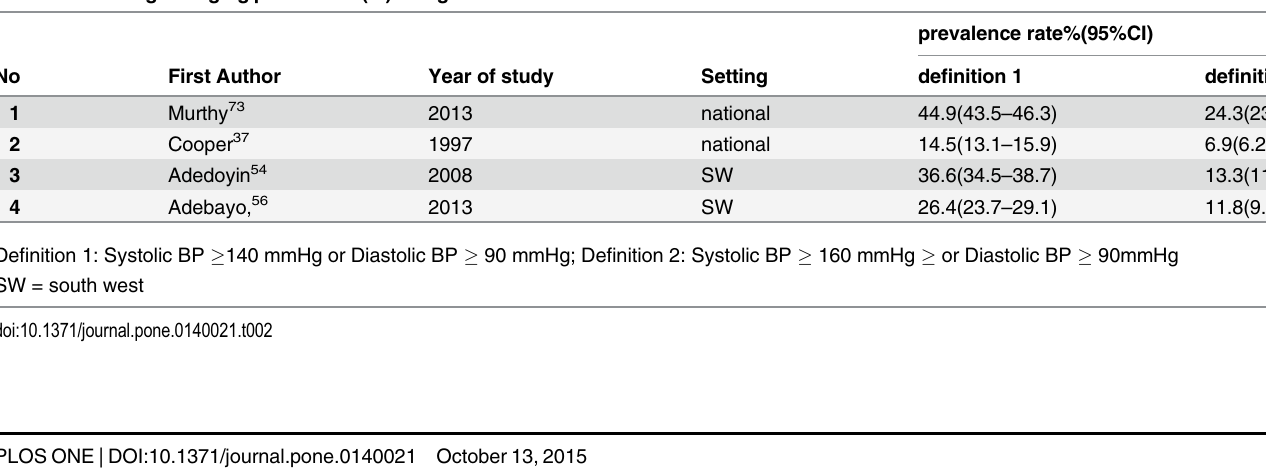
Table 2. Showing changing prevalence (%) using different BP